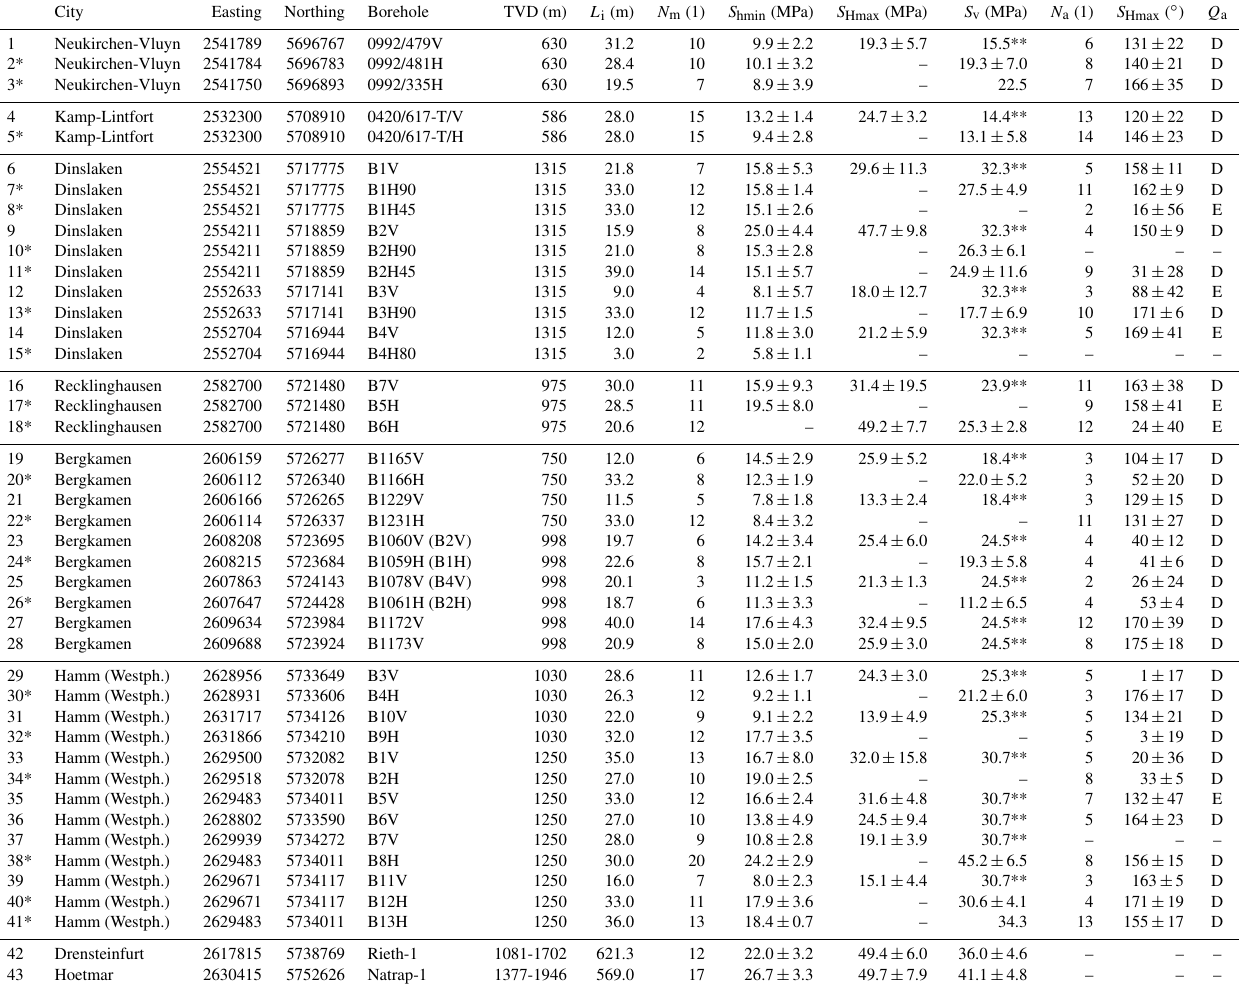
Table 2. Results of hydrofracturing tests performed across the greater Ruhr region (TVD – true vertical depth, L i – length of a test interval, N m – number of stress magnitude tests, S hmin – magnitude of the minimum horizontal stress, S Hmax – magnitude (and orientation) of the maximum horizontal stress, S v – magnitude of the vertical horizontal stress, Q a – quality of the S Hmax orientation data record). Easting and northing were presented according to the EPSG:31466 geographical